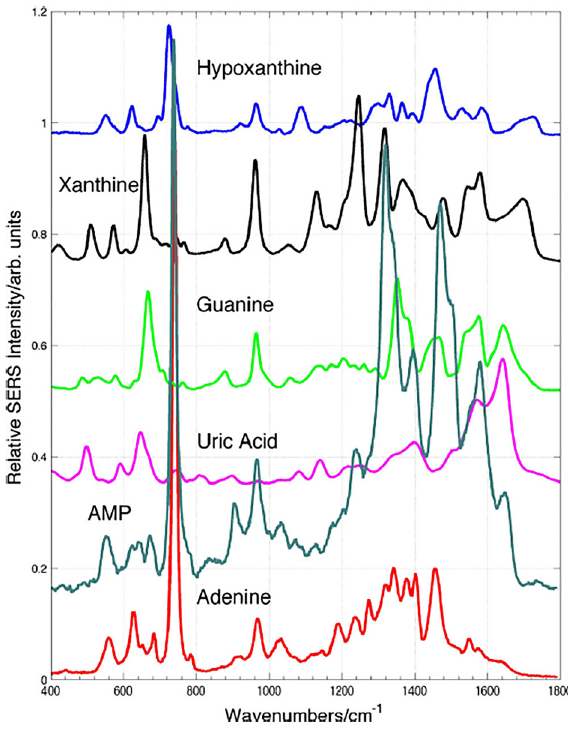
Figure 6: Surface-enhanced Raman spectroscopy (SERS) spectra of 20 μ M aqueous solutions of the indicated purine components of bacterialSERSspectra.Thespectrahavebeenoffsetforviewingand are normalizedto the maximumpeak intensity of the 20 μ M adenine solution. AMP adenosine monophosphate. Reprinted with permission from Premasiri et al. [55]: Springer Nature, Copyright